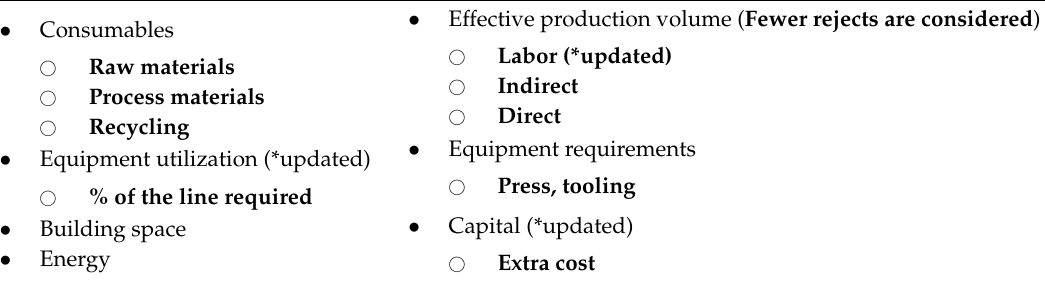
Table 7. Main PBCM elements considered for Lite RTM (LRTM).